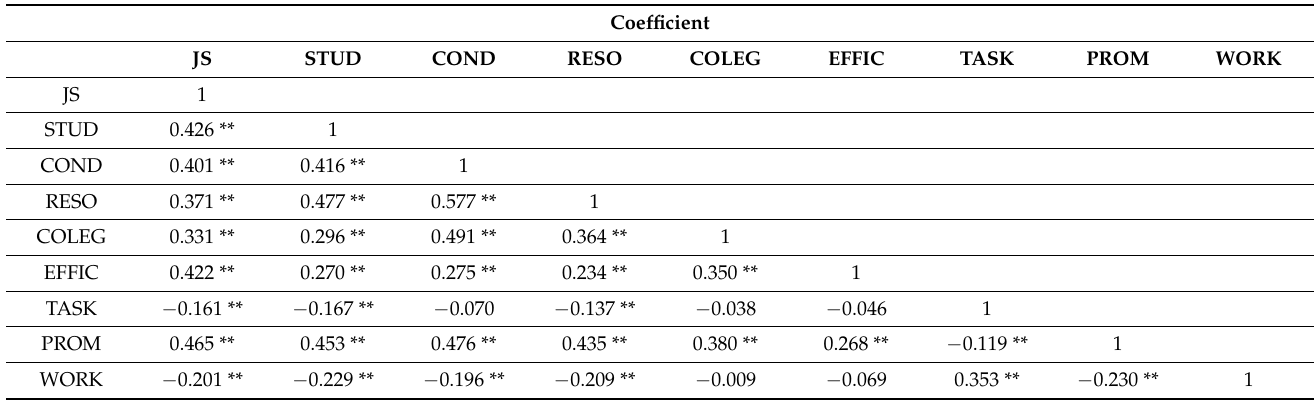
Table 3. Correlation coefficient.